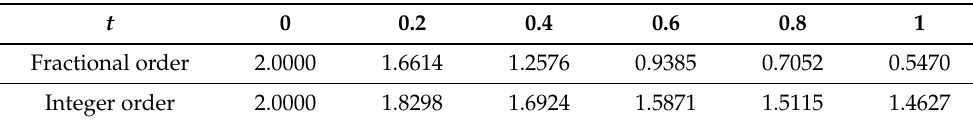
Figure 5. Simulation of solutions in Example 3. Table 3. Comparison of numerical solutions of u ( t ) in Example